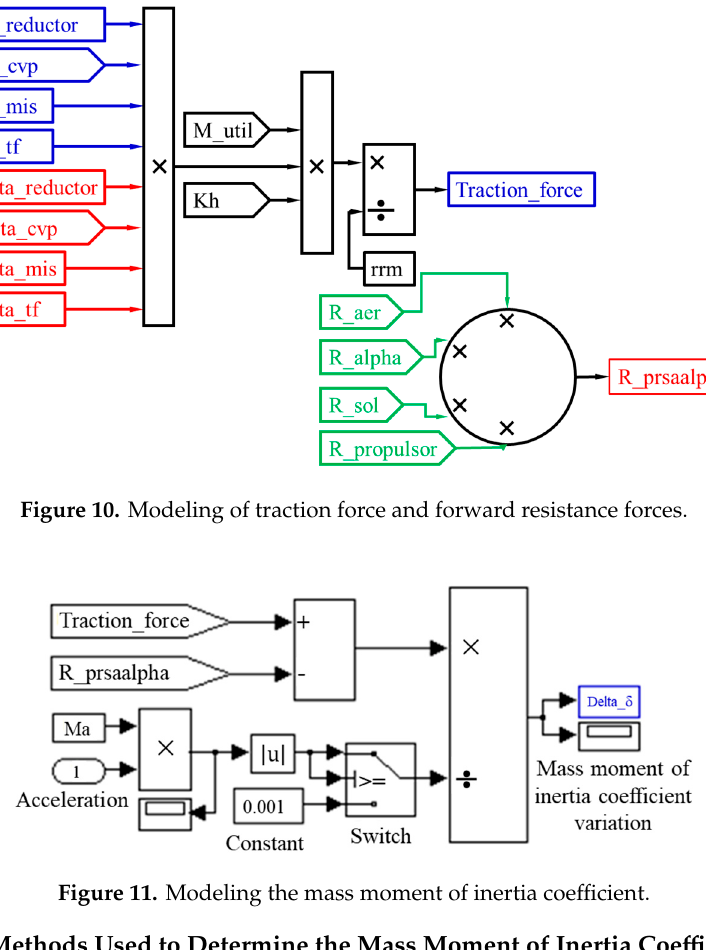
Figure 11. Modeling the mass moment of inertia coefficient.